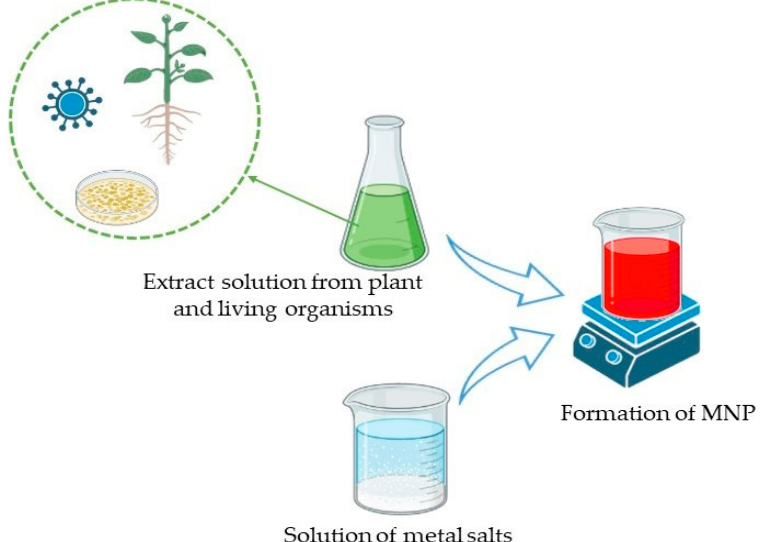
Figure 1. The biological method for the synthesis of MNP.